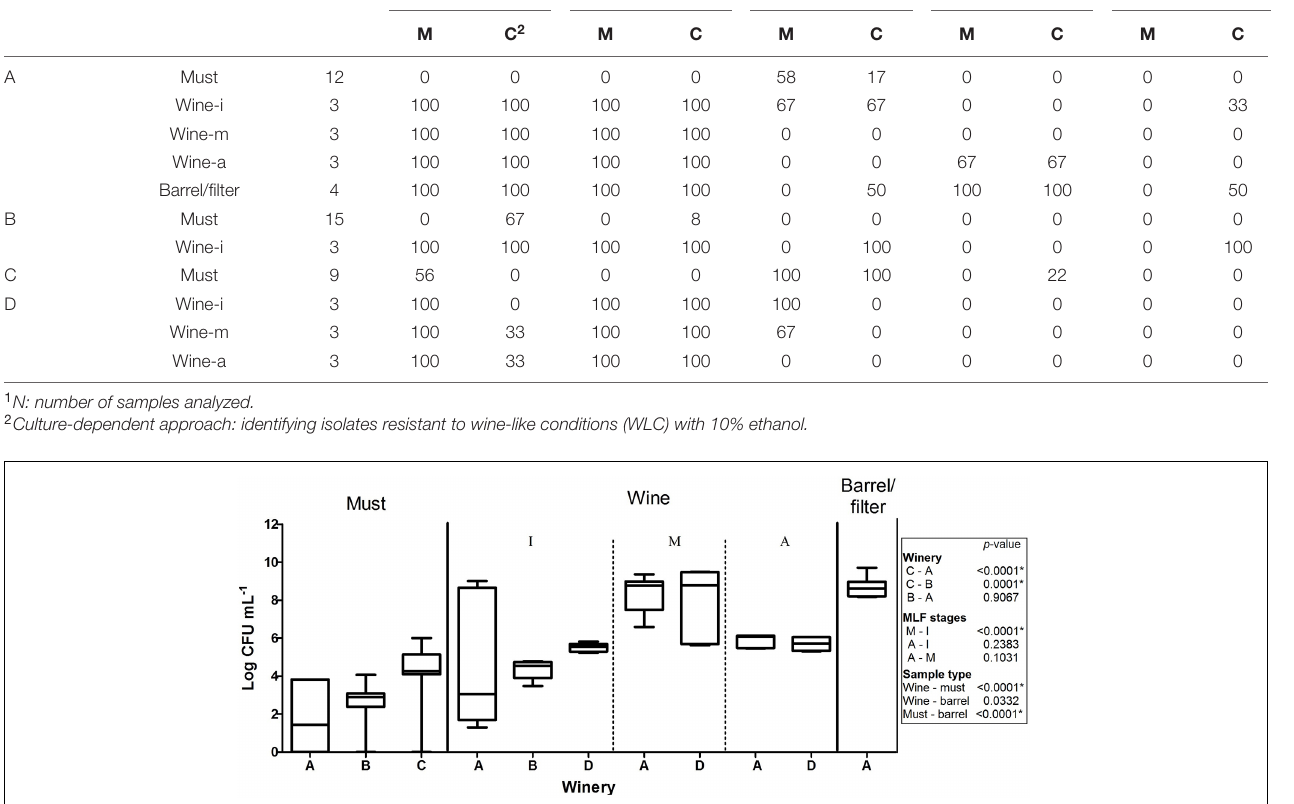
TABLE 4 | Percentage of incidence of LAB species detected by culture (C) and molecular assay (M) in samples of must, wine in three stages of malolactic fermentation (MLF): Initial (i), middle (m), and advanced (a) and barrel/filter; obtained in wineries A, B, C, and D. Winery Sample type N 1